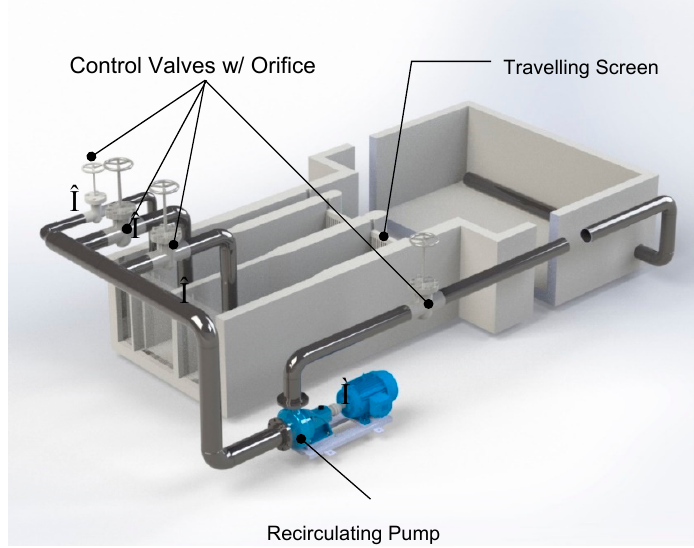
Figure 1. 3D rendering of the 1:10 undistorted scale hydraulic model test.